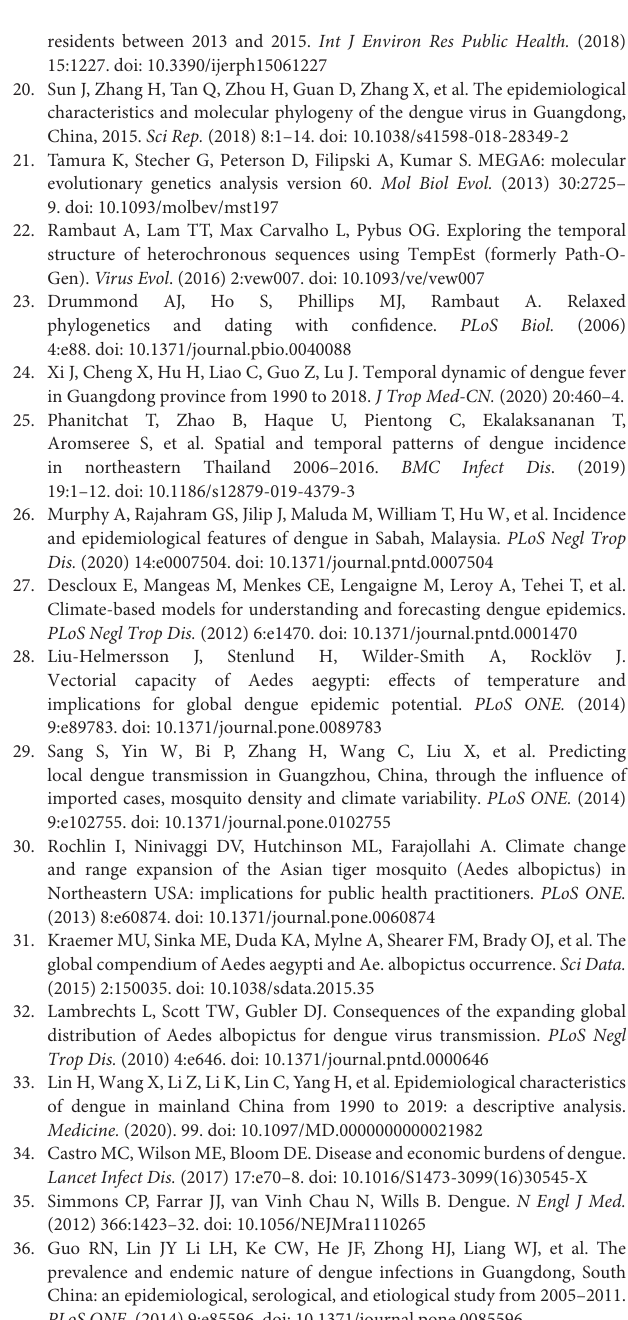
Supplementary Figure 4 | Bayesian evolutionary tree of suspected local evolutionary branch in DENV 1 genotype I. Source countries/regions of the strains of DENV 1 genotype I are presented by different colors. Supplementary Figure 5 | Bayesian evolutionary tree of DENV 1 genotype IV. Source countries/regions of 3 clusters of DENV 1 genotype IV are presented by colors. Supplementary Figure 6 | Bayesian evolutionary tree of DENV 1 genotype V. Source countries/regions of 3 clusters of DENV 1 genotype IV are presented by colors.